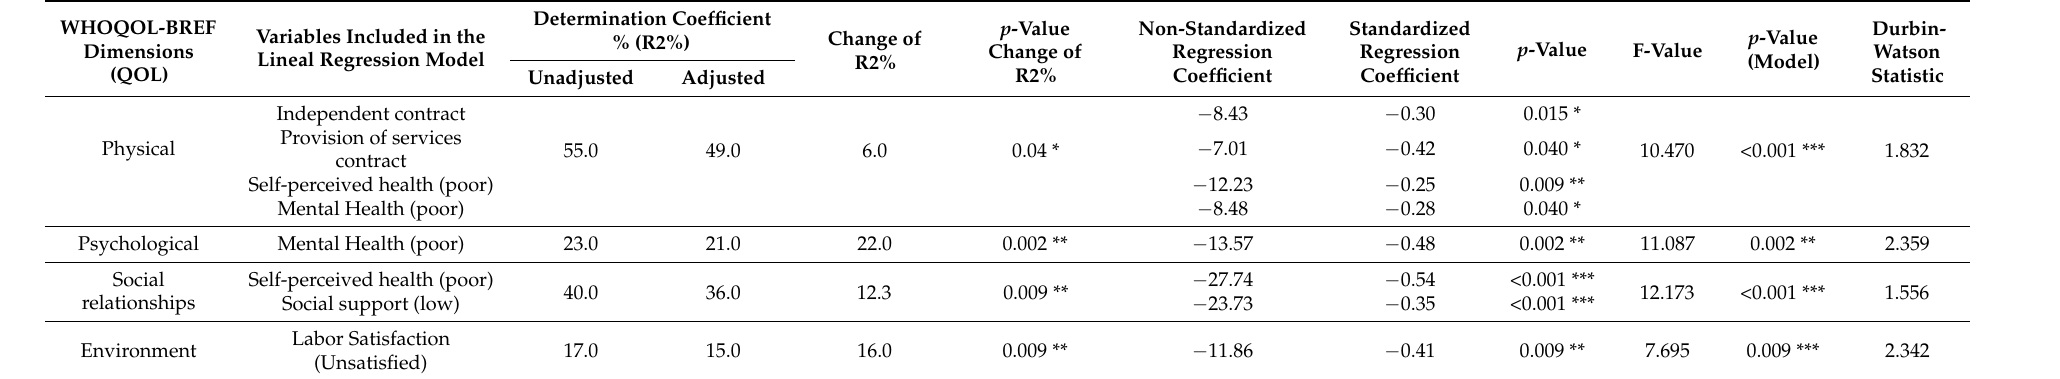
Table 4. Lineal regression models for the scores of the WHOQOL-BREF dimensions of quality of life according to the variables included in the study sample. Medell í n, 2021–2022 ( n =